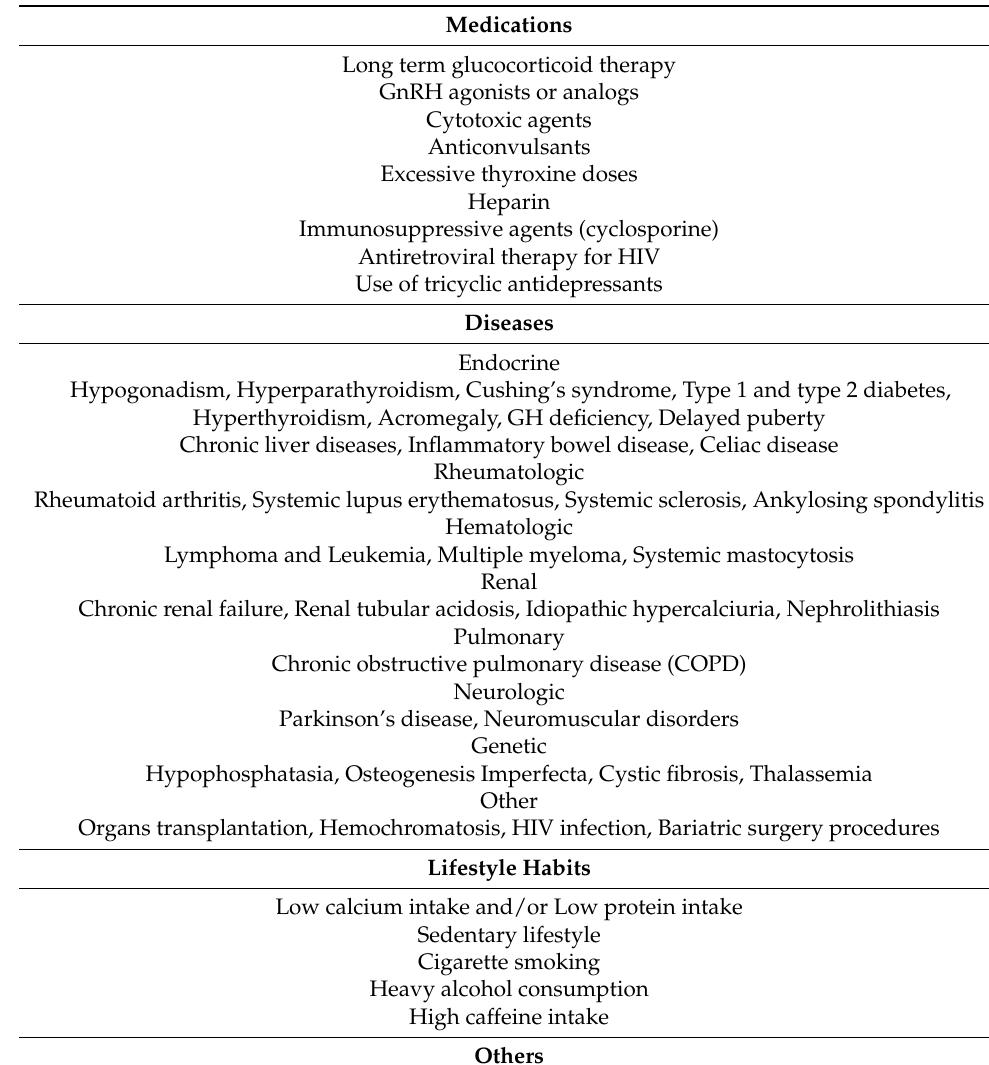
Table 1. Conditions described as inducing osteoporosis in